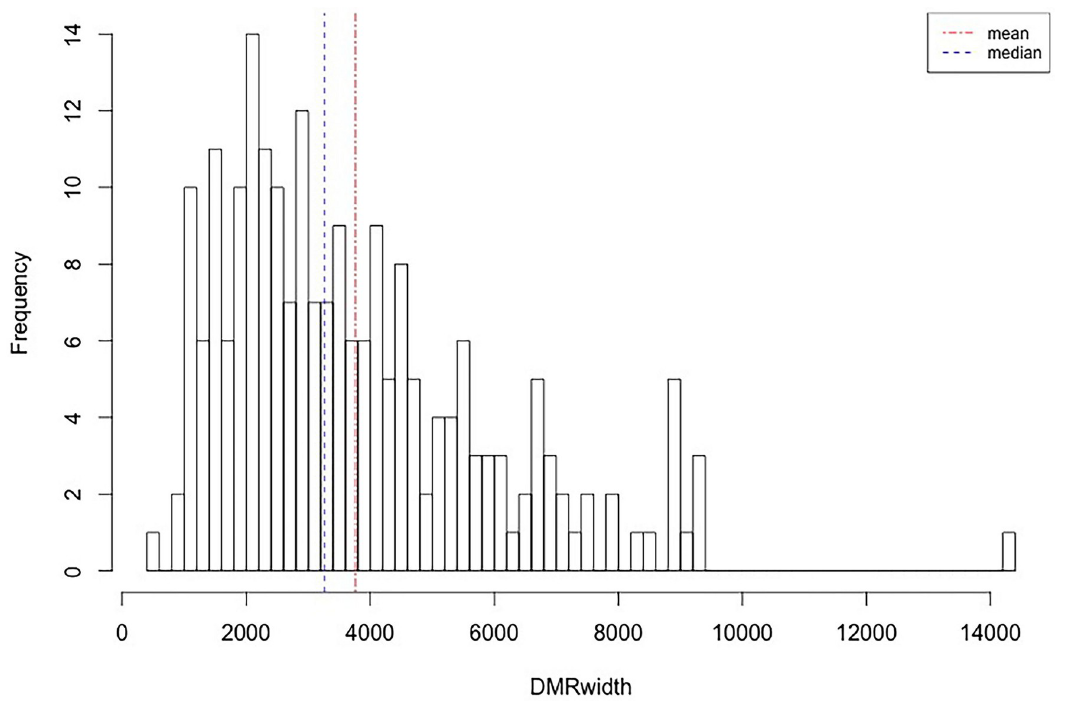
Fig 3. DMRs’ length density. The abscissa represents the extent of the DMRs in base pairs. The dotted light blue and red lines correspond for the median and mean